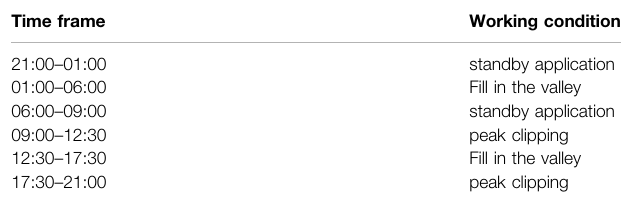
TABLE 7 | Distribution table of peak cutting and valley fi lling period.